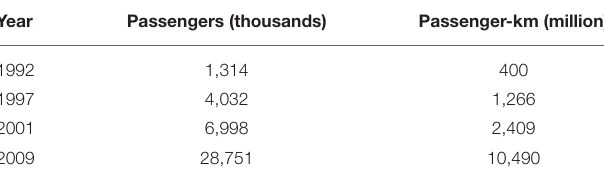
TABLE 4 | Spain’s High-Speed Rail Passenger